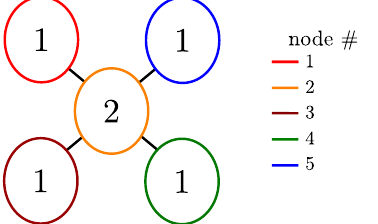
Figure 5. The 3d N = 4 quiver based on the a(cid:14)ne D 4 Dynkin Diagram. We number the nodes in the quiver as per the coloring scheme shown in the